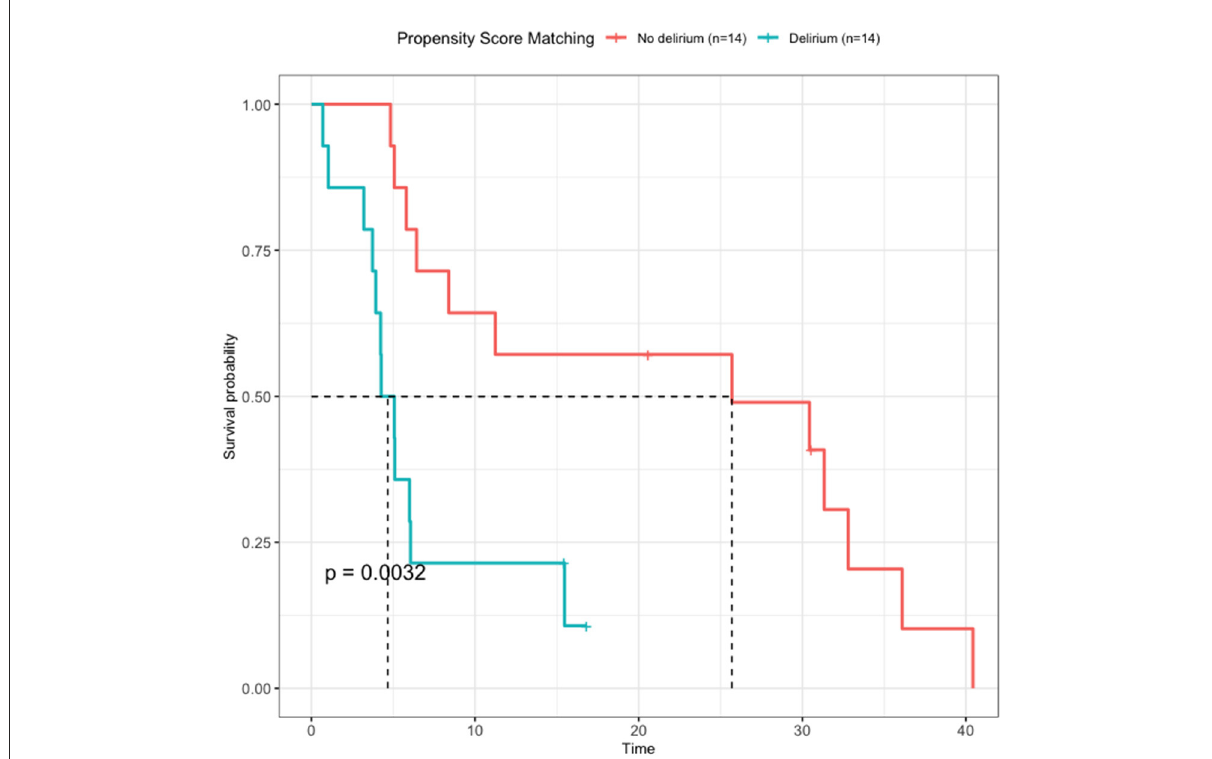
FIGURE4 Survival analysis by delirium after propensity score matching. The non-delirium group had a median survival of 25.7 months, while the delirium group had a median survival of 4.67 months ( P =